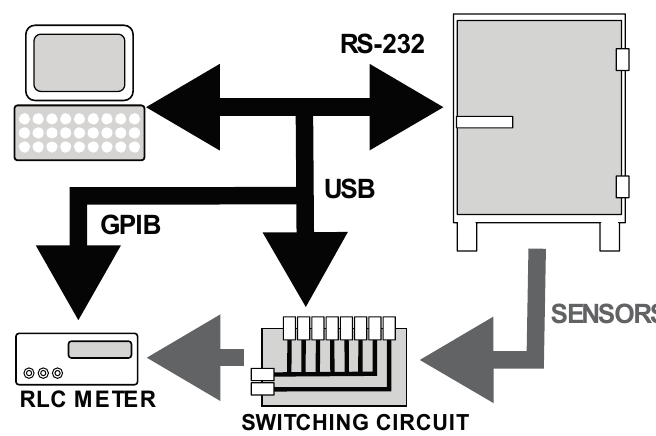
Figure 3. Evaluation